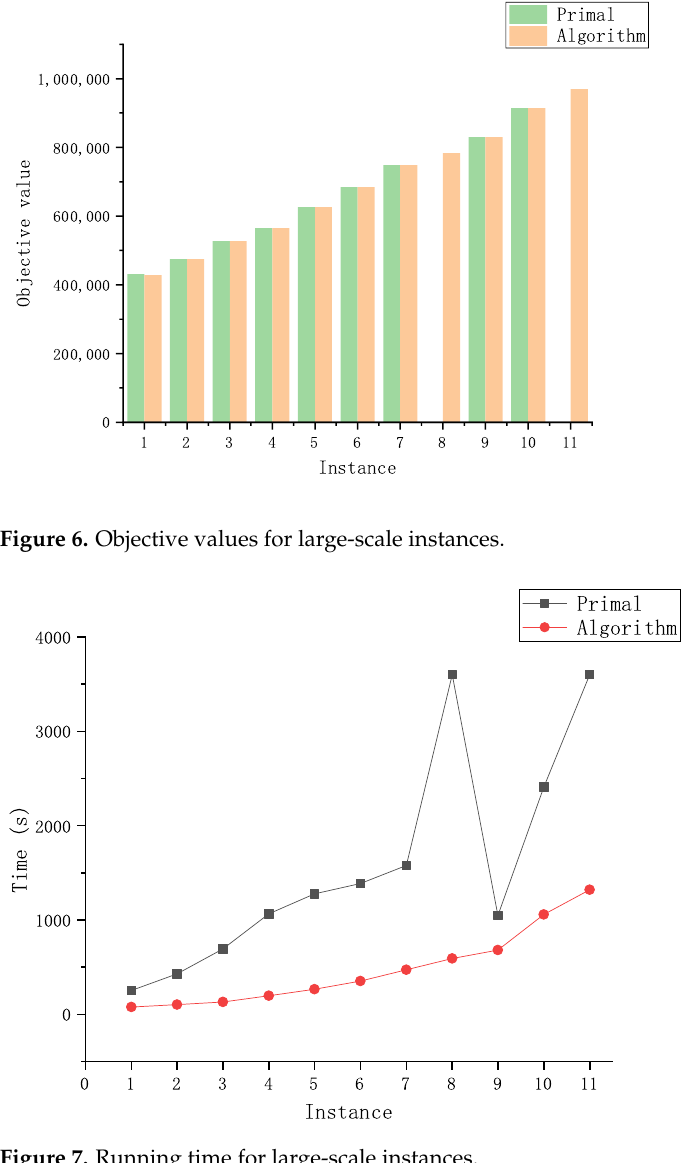
Figure 7. Running time for large-scale